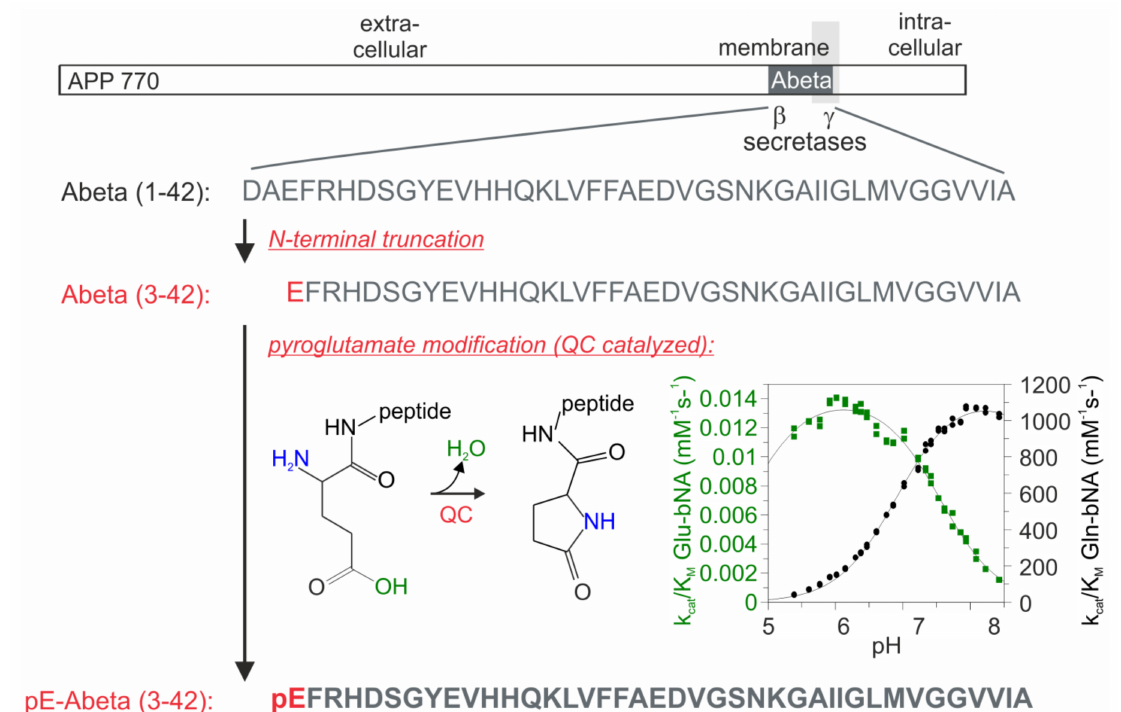
Figure 1. Sequential generation of pE-Abeta peptides. Abeta(1–42) peptides are generated by β -secretase and γ -secretase cleavage of amyloid precursor protein (APP). After N-terminal removal of two amino acids, a glutamate residue (E, red) is exposed at position 3 of Abeta(3–42) and can be converted by the enzymatic activity of glutaminyl cyclase (QC) to pE resulting in the peptide pE-Abeta(3–42). The enzymatic reaction of pE formation and kinetic characteristics are shown in the bottom figure. Note the 5-oxoproline ring formation under liberation of water (left) and the slow conversion of N-terminal glutamate under slightly acidic pH conditions (green curve), as compared with the much faster pE formation from N-terminal glutamine (black curve; right). Enzymatic presentations are adapted from Schilling et al.